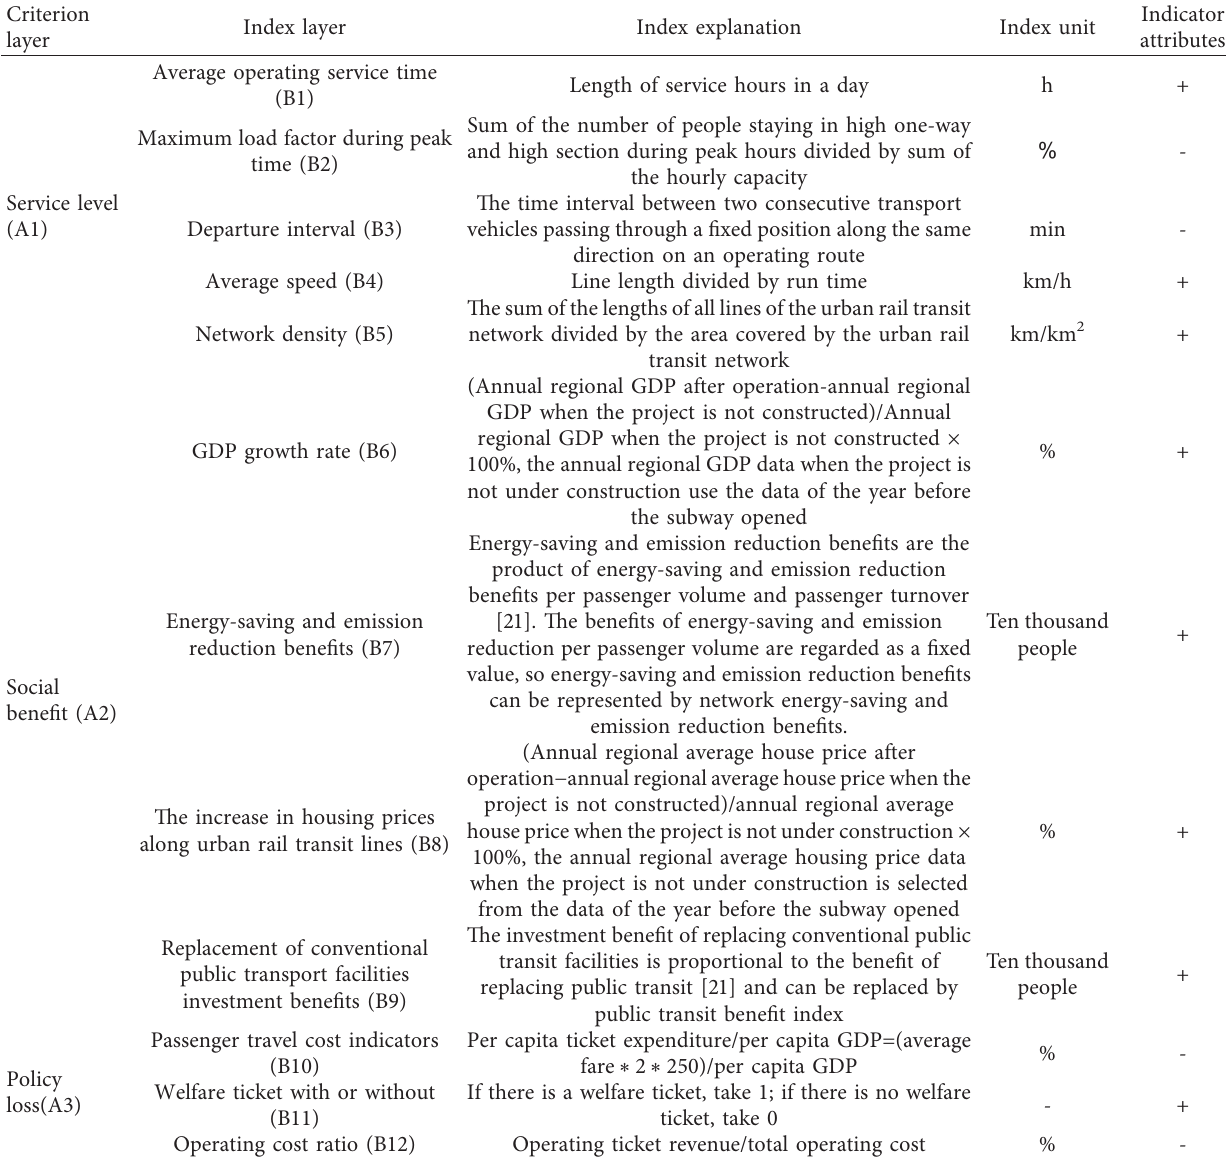
Table 1: Public welfare level evaluation index system of urban rail